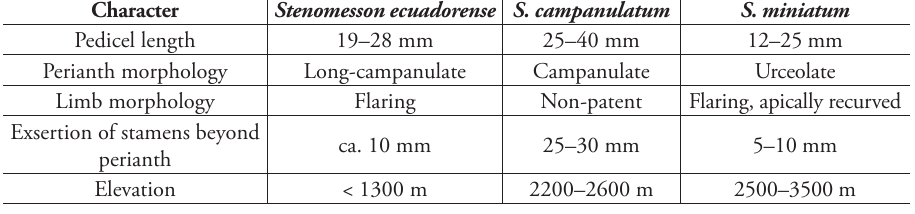
Table 1. Contrasting features of Stenomesson ecuadorense , S. campanulatum and S.miniatum .